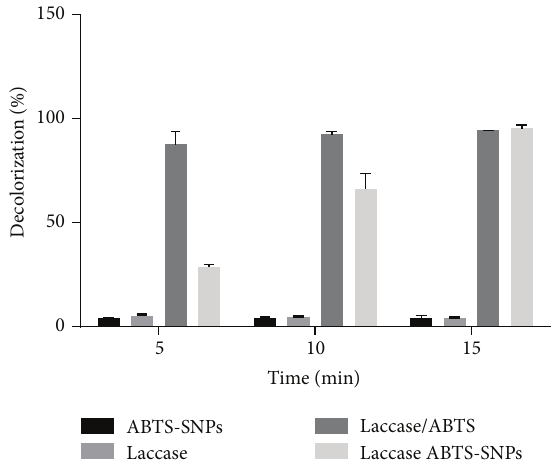
Figure 4: Decolorization of indigo carmine (20 mg/L) by ABTS- SNPs (10g/L containing 70 𝜇 M ABTS), laccase (3000 U/L), laccase/ ABTS-SNPs, and laccase/ABTS (70 𝜇 M ABTS) in 50mM sodium acetate buffer at pH 4.5 with shaking at 150 rpm at room temper- ature.